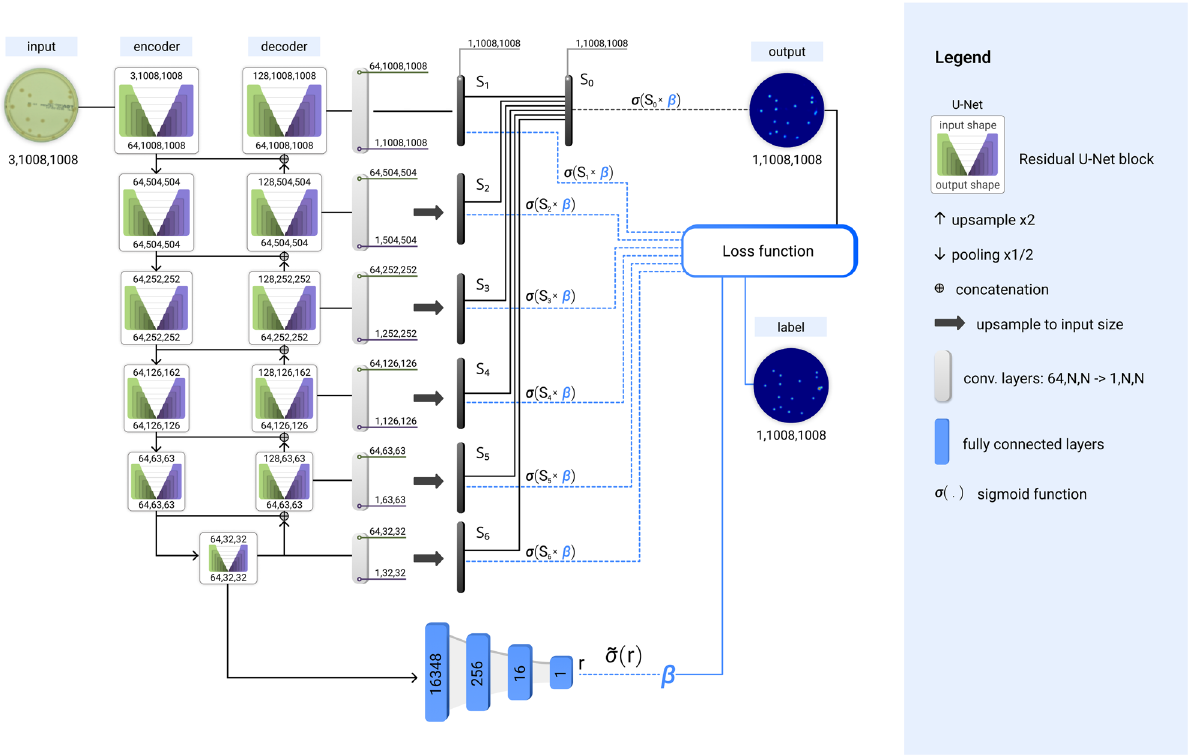
2 Figure 1. SNDM network: U -Net extended by the normalization bypass-layers (blue) that output β normalization parameter. Note that β parameter multiplies last layers of the U density map.